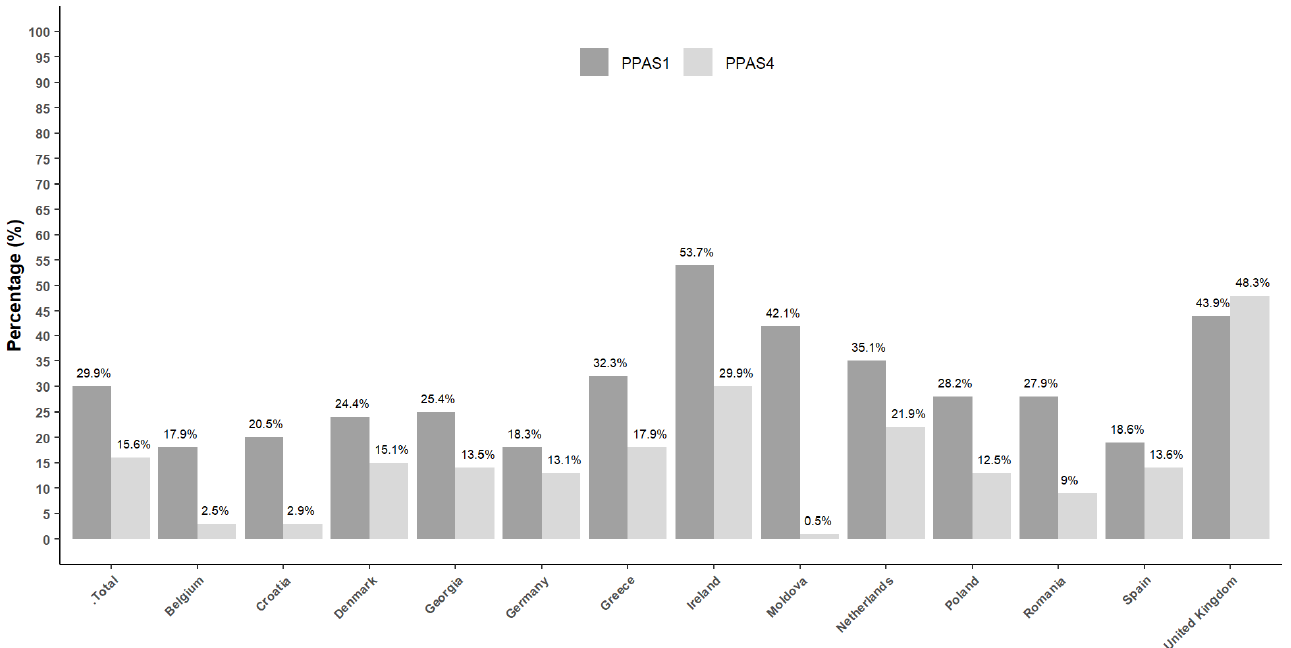
Figure 1. Overview of the percentage of consultations resulting in an antibiotic prescription, overall and by GPs in each country in PPAS-1 and PPAS-4.